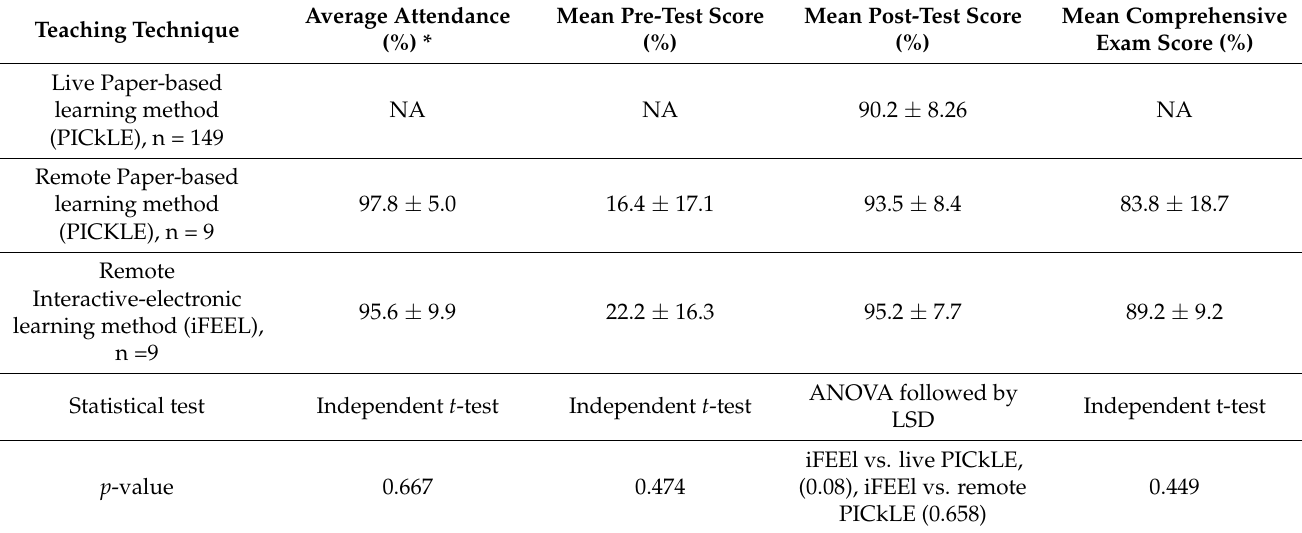
Table 1. Students’ average attendance, participation, and exam